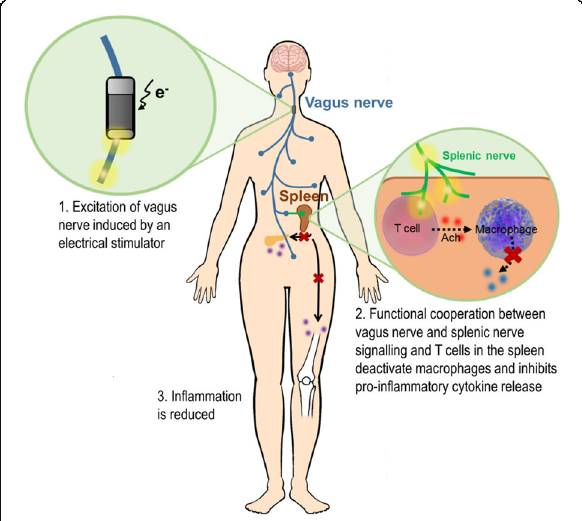
Fig. 2 Schematic representation of a bioelectronic approach at targeting the vagus nerve to control inflammation. Vagus nerve signalling interacts with the splenic nerve that reaches splenic T cells that produce acetylcholine, which reduces